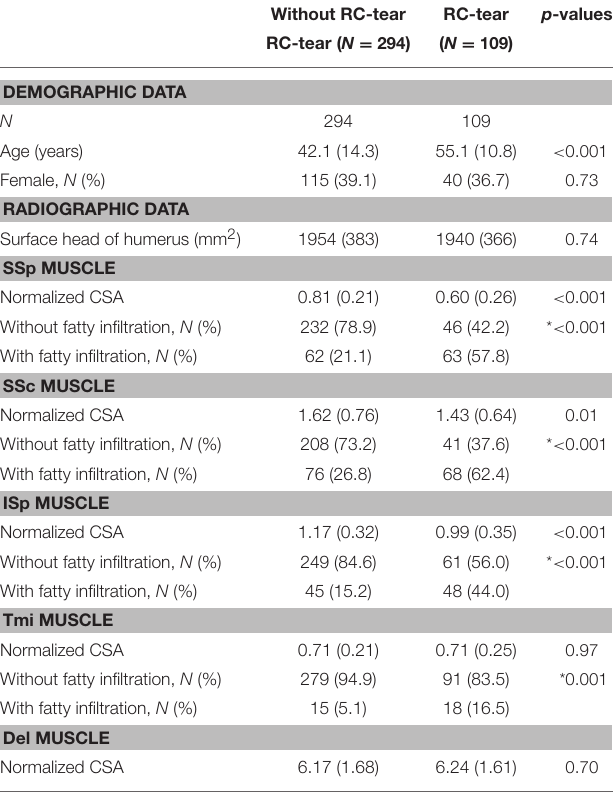
TABLE 1 | Characteristics of